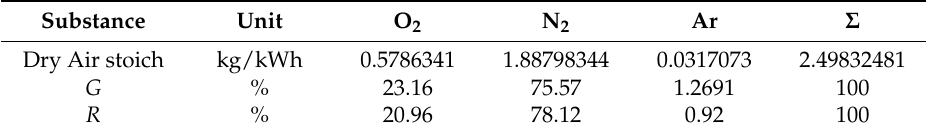
Table 6. Stoichiometric Air Consumption and Composition.